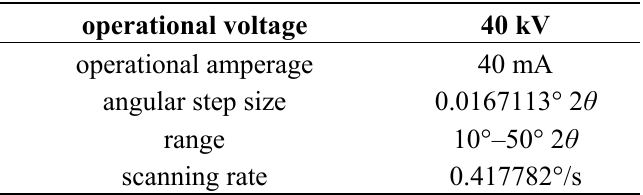
Table 3. Measurement setup for X-ray diffraction.